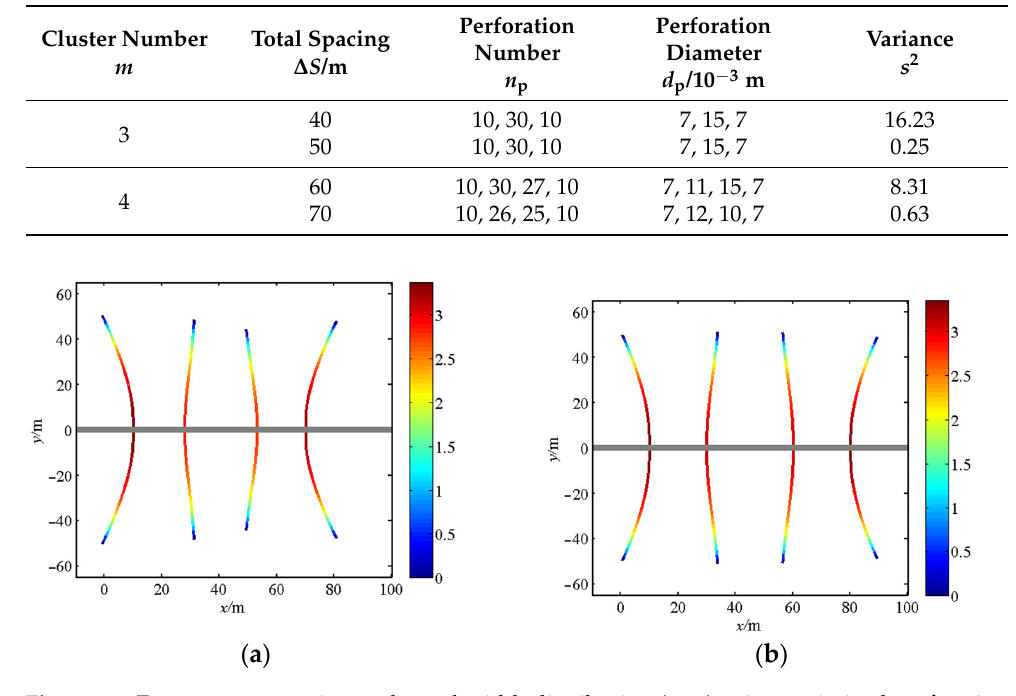
Figure 11. Fracture propagation paths and width distribution (mm) using optimized perforation parameters with different total spacings: ( a ) 60 m; ( b ) 70 m.